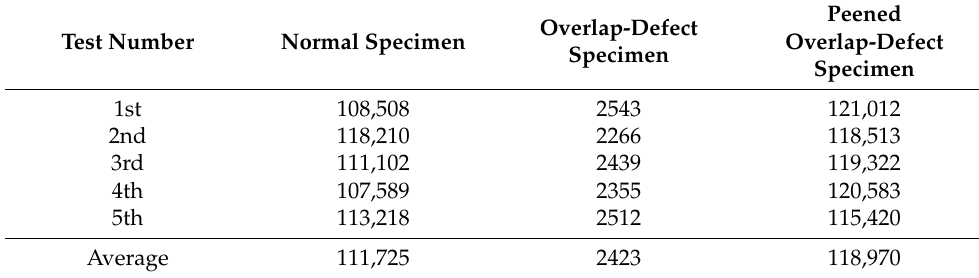
Table 3. Fatigue test results: number of cycles to